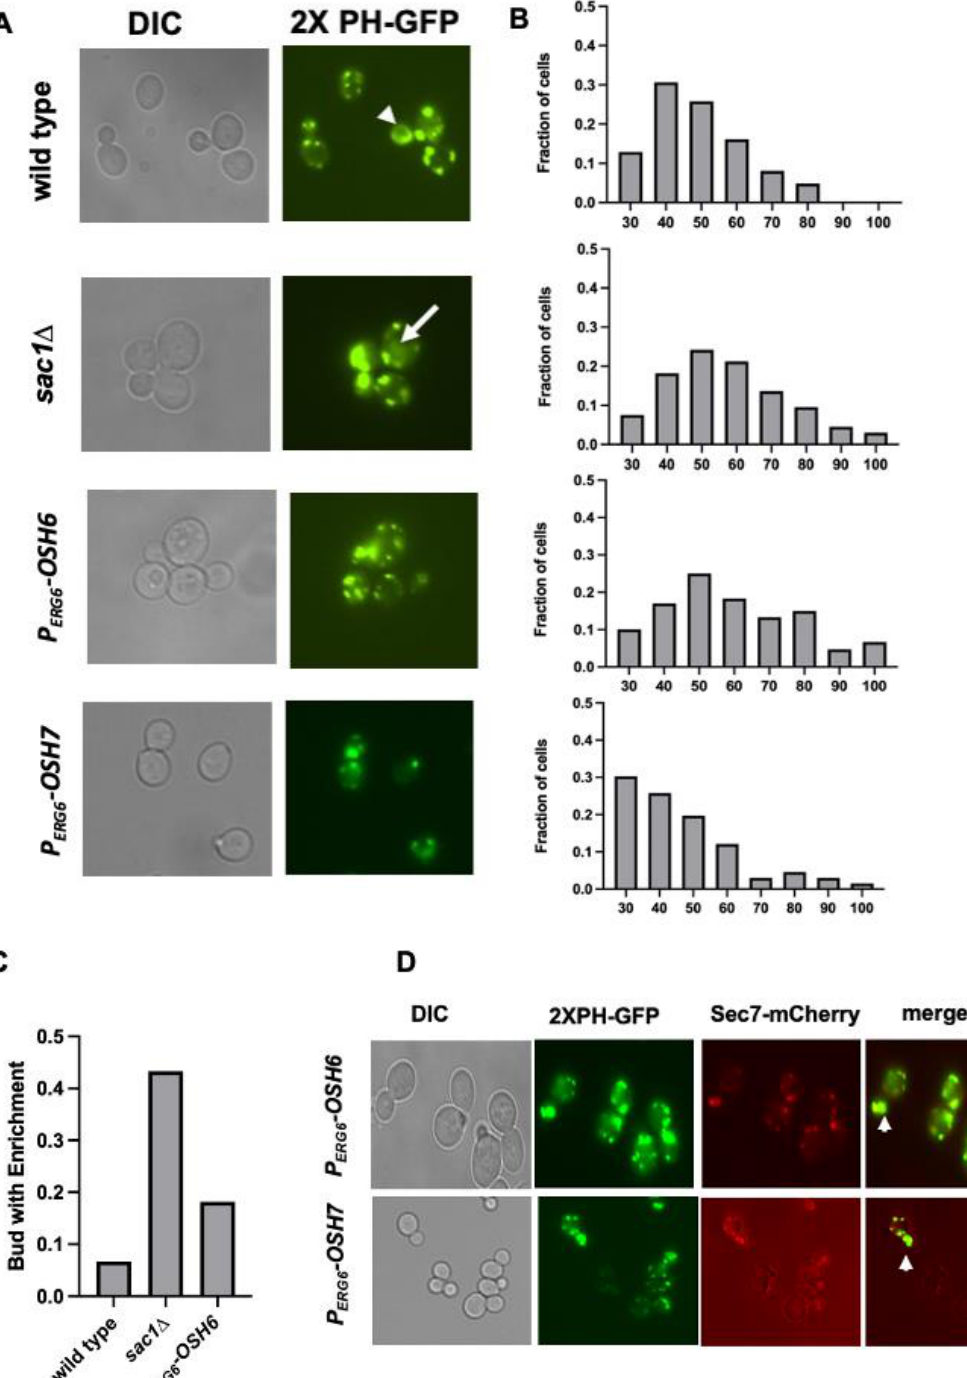
FIGURE 2: Up-regulation of Osh6 traps PI4P on the Golgi . (A) Comparison of the localization of PI4P in wild type (BY4742), sac1 ∆ , P ERG6 - OSH6 (FTY536), and P ERG6 - OSH7 (FTY521). The indicated strains were transformed with the 2XPH-OSBP-GFP plasmid, grown to early log phase and photo- graphed. The arrowhead points to a cell with PI4P on the PM in addition to intracellular punctate. The arrow points to a cell with PI4P-decorated circular organelles in sac1 ∆ . (B) Distribution of cells with different PI4P intensities. The intensity of PI4P of each cell was measured by the ImageJ software. Then cells were grouped based on the relative PI4P intensity with a ten arbitrary unit (reported by ImageJ) interval (X-axis). The fraction of each group in the whole set is presented on Y-axis. Sample sizes are 61 for wild type, 64 for sac1 ∆ , 83 for P ERG6 - OSH6 , and 69 for P ERG6 - OSH7 . (C) Dis- tribution of cells with bud-enriched PI4P in different strains. A cell was counted as ‘bud enriched’ if its bud PI4P signal/(bud signal + mother signal) is larger than 0.6. Sample sizes are 31 for wild type, 34 for sac1 ∆ and 35 for P ERG6 - OSH6 . Fisher exact test shows that sac1 ∆ is significantly different from wild type (P=0.029) and that P ERG6 - OSH6 is not significantly different from wild type. (D) PI4P colocalized with the trans-Golgi network marker Sec7- mCherry. Cells of the Sec7-mCherry integrated version of P ERG6 - OSH6 (FTY624) and P ERG6 - OSH7 (FTY625) strains were transformed with the 2XPH- OSBP-GFP plasmid. Early log phase cells of the transformants were photographed under FITC or Texas Red filter. Representative images are shown here. Arrow heads point to areas where PI4P overlapped with